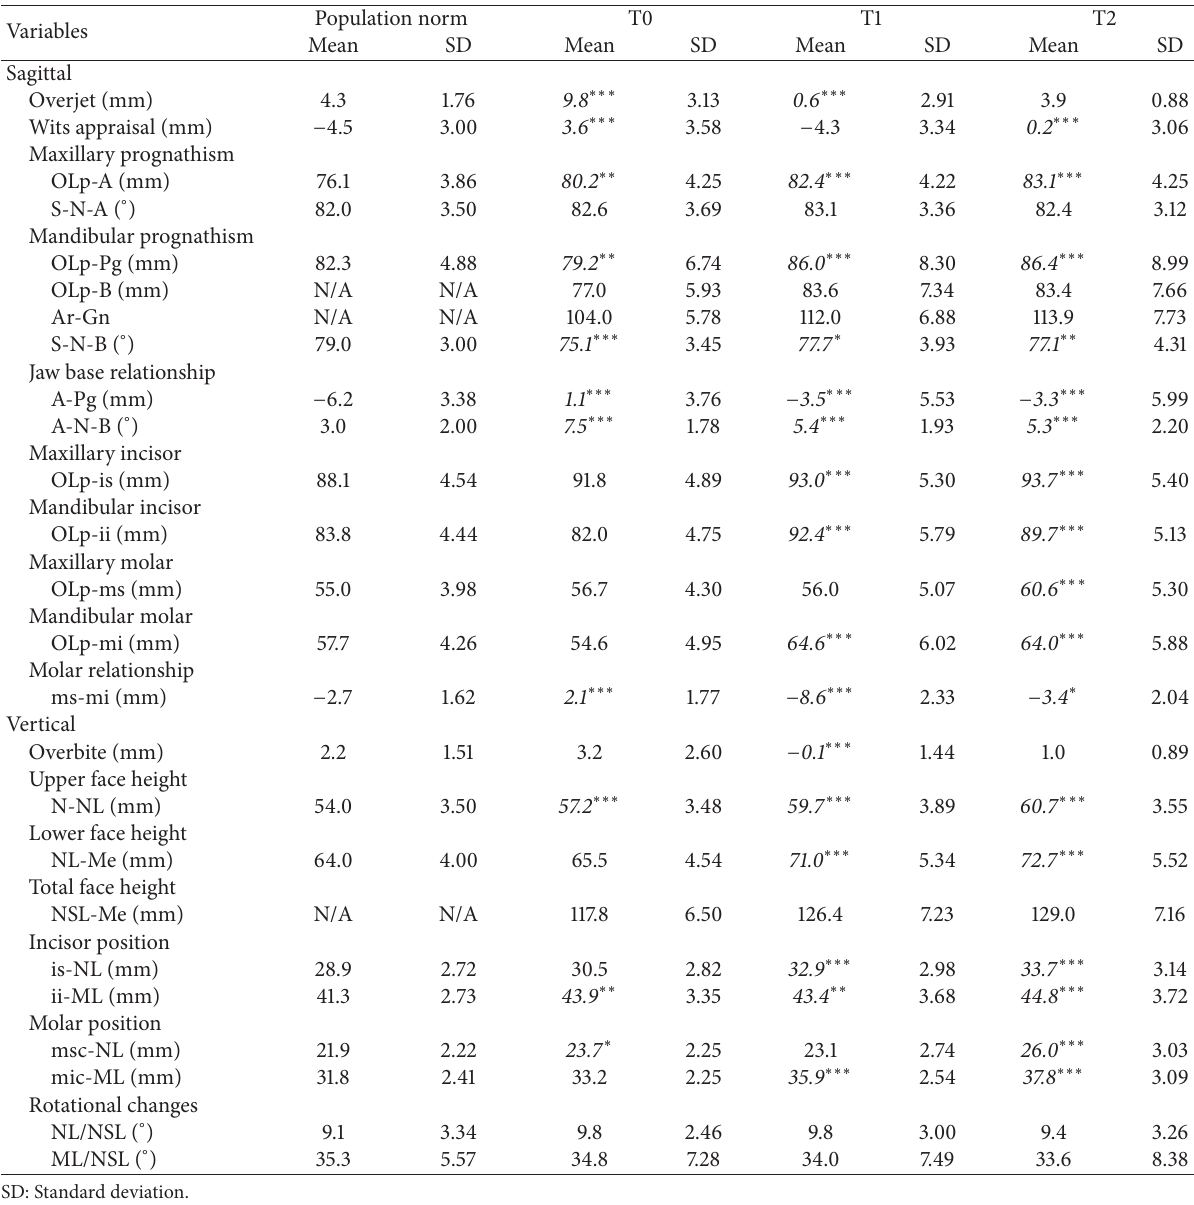
Table 2: (a) Comparison of dentofacial morphology between the population normand the study sample at the start of treatment (T0) and after phase I (T1) and phase II (T2) treatment. (b) Comparison of dentofacial morphology with the population norm and the three subgroups at the start of treatment